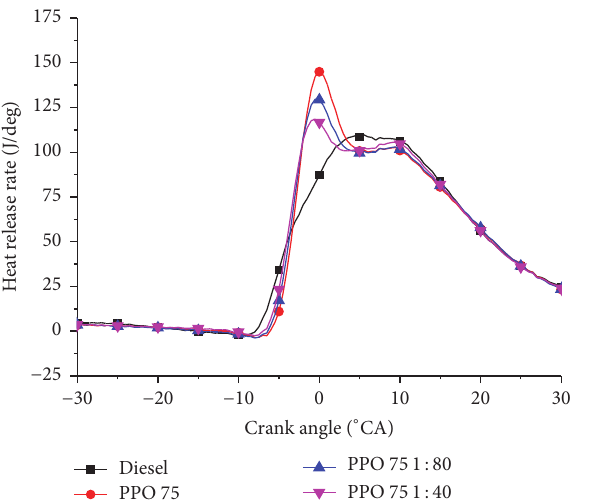
Figure 11: Normalized values of CO, UHC, and NOx emissions.